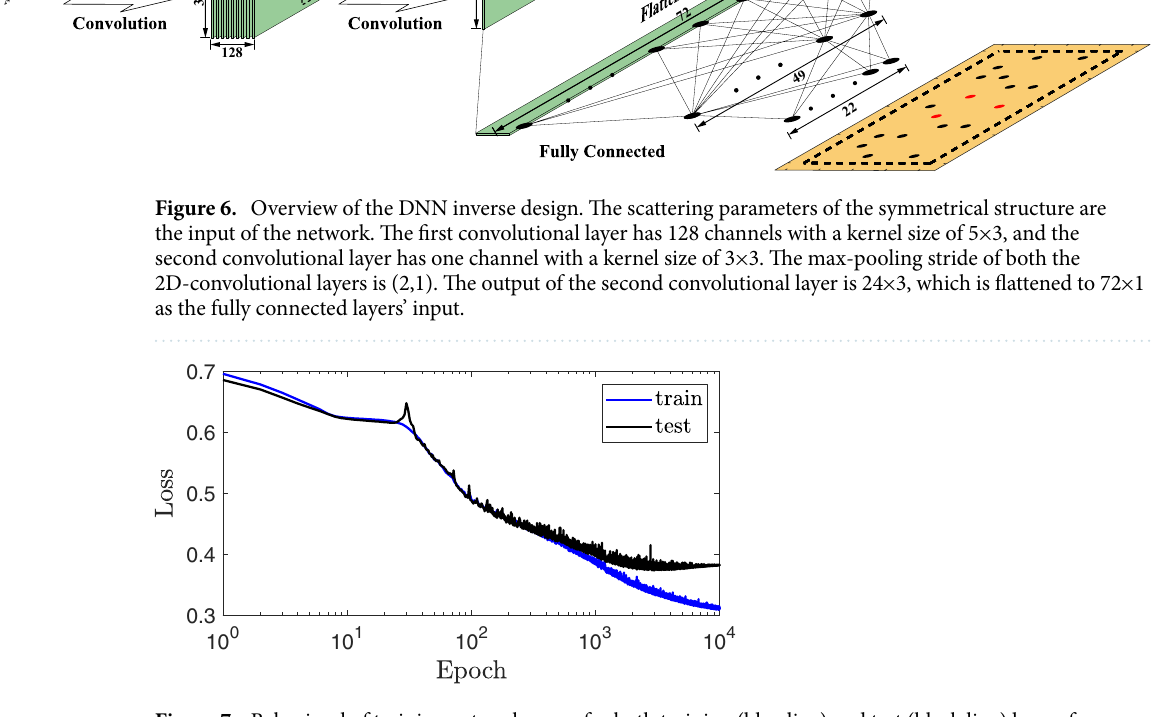
Figure 7. Behavioral of training network curve for both training (blue line) and test (black line) losses for 10, 000 epochs, based on the Binary Cross-Entropy as cost functions, which has a low loss value of ∼